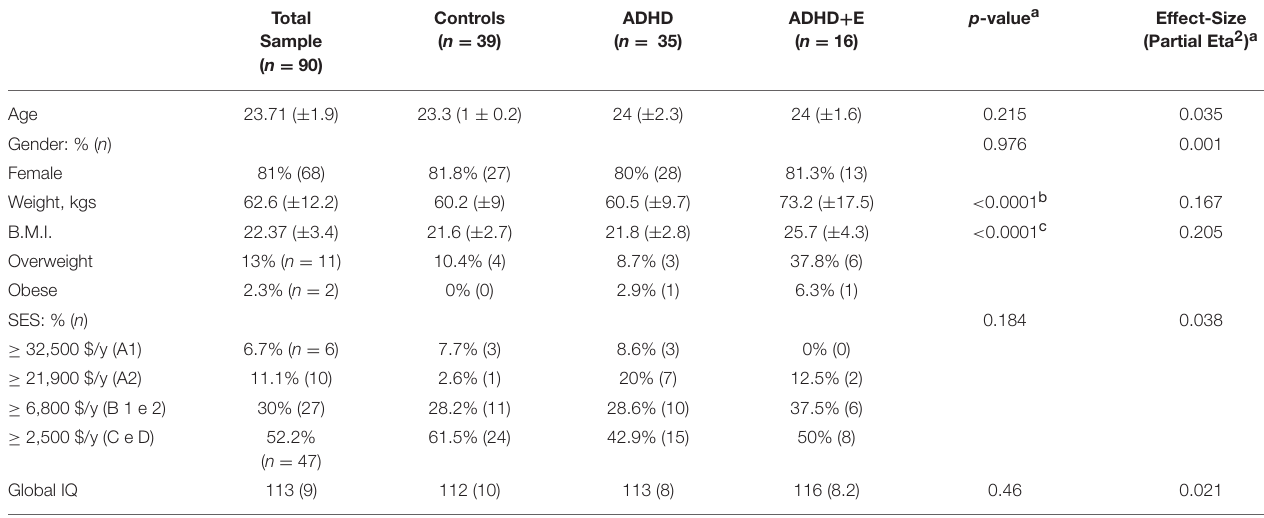
TABLE 1 | Subjects sociodemographic and clinical